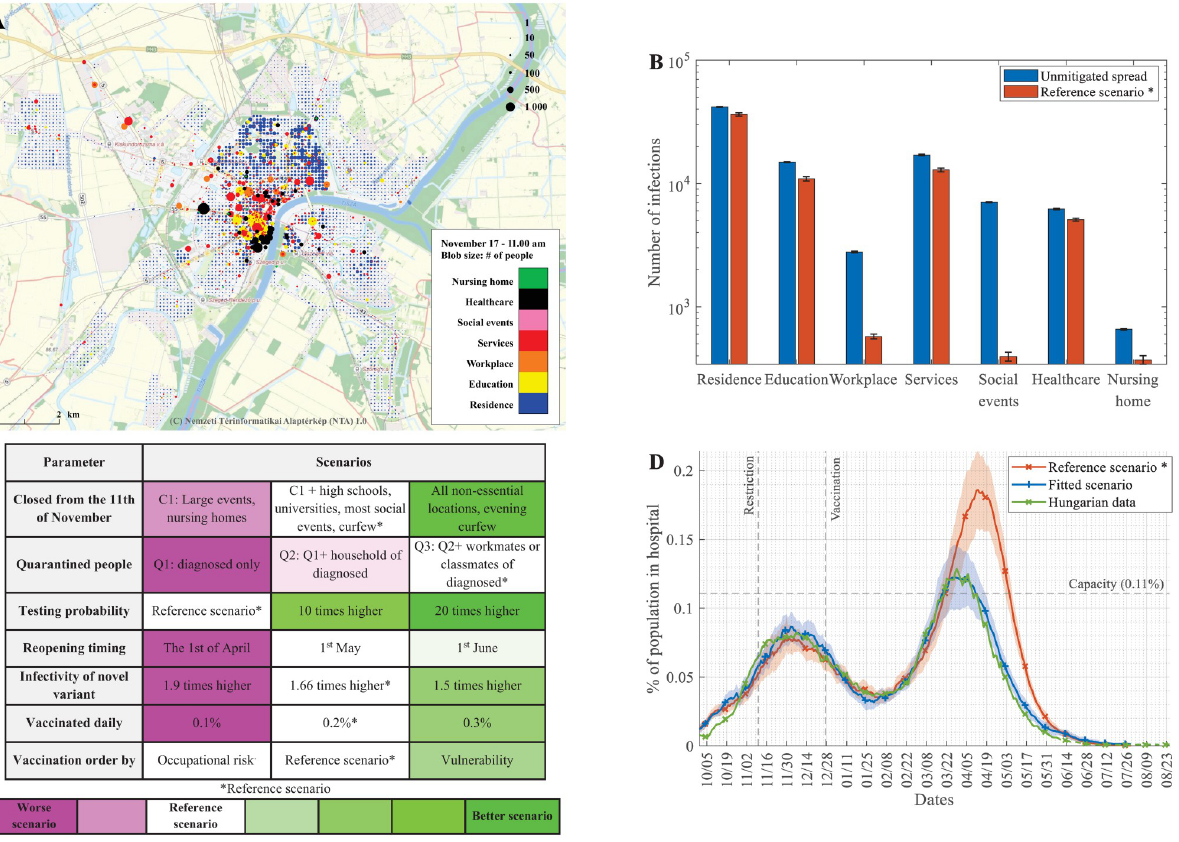
Fig 1. PanSim maps simulated population movements and projected infections onto specific locations in the virtual city emulating Szeged. (A) Institutions and households are localised in a virtual city. Colour codes represent different types of locations, and node sizes increase linearly with the number of infected people (see an animated version of this map at https://youtu.be/OCfbHjLeCbY). (B) Distribution of infection events at various types of locations when the virus is unmitigated or when restrictions from the reference scenario are applied. (Note the logarithmic scale, error bars show the uncertainty of 20 simulations.) (C) Projected sensitivity of the pandemic with various intervention types and levels. Colour code shows the severity function of the pandemics for the labelled changes. (Details on the analysed scenarios can be found in Table F in S1 Text. (D) Comparing actual hospitalisation data [36] to the fitted and the reference scenario simulations. (Mean and std. of 30 simulations are shown).